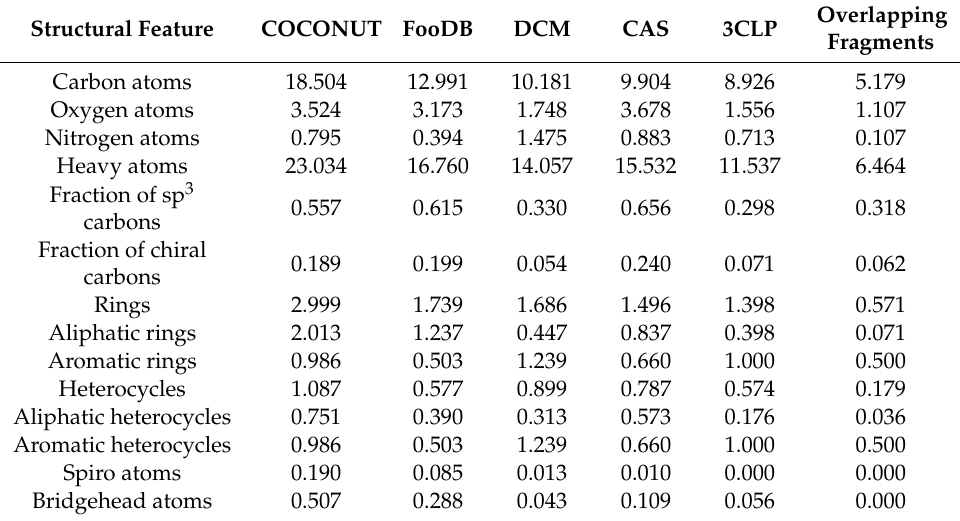
Table 3. Summary of the structural composition of fragments from COCONUT, FooDB, CAS, DCM, and 3CLP and overlapping fragments a